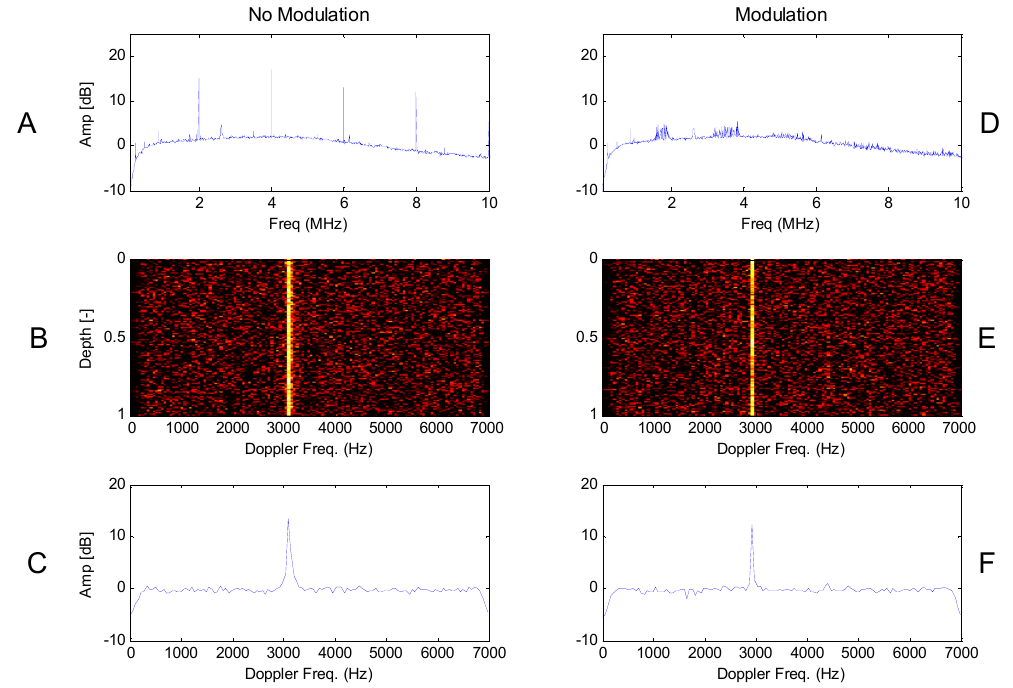
Figure 7. Measurements of the noise produced by a switching-regulator working at 1.8 MHz in a Doppler system with T Pri = 142.86 µ s. ( A , D ) Spectrum of the noise as input into the Doppler system; ( B , E ) Doppler spectral matrix; ( C , F ) spectral density averaged over depths ( k -index).